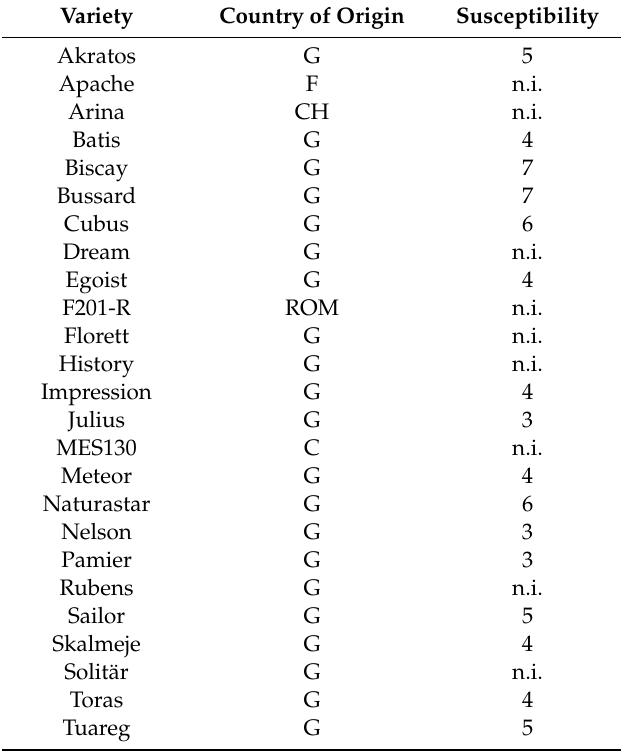
Table 1. Tested wheat varieties and their susceptibility to Z. tritici as classified by the German Federal Plant Variety O ffi ce (Bundessortenamt, 2012); 1 = low susceptibility, 9 = high susceptibility, n.i. = no information. Variety Country of Origin Susceptibility Akratos G 5 Apache F n.i. Arina CH n.i. Batis G 4 Biscay G 7 Bussard G 7 Cubus G Dream G n.i. Egoist 4 F201-R ROM n.i. Florett G n.i. History G n.i. Impression G 4 Julius G 3 MES130 C n.i. Meteor G 4 Naturastar G 6 Nelson G Pamier 3 Rubens G n.i. Sailor G 5 Skalmeje G 4 Solitär G n.i. Toras